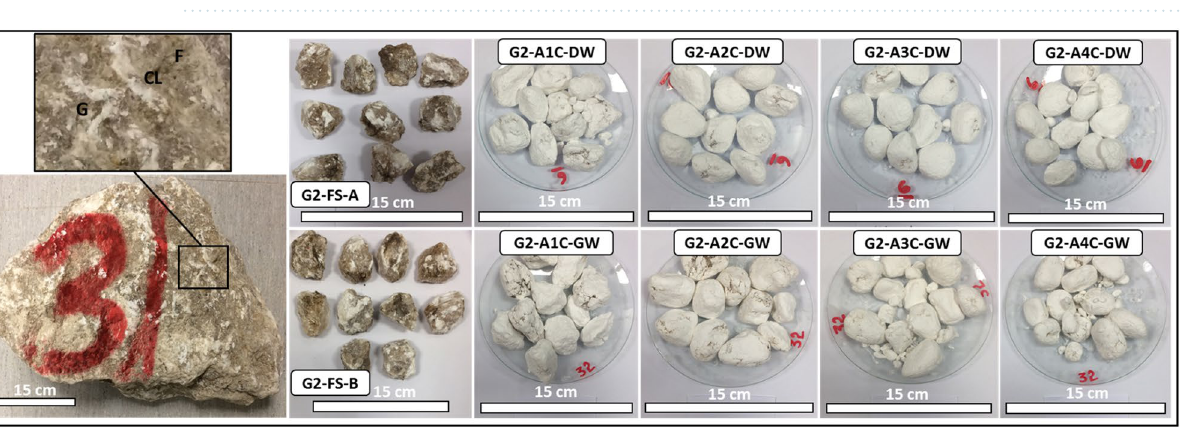
Figure 3. Representative evaporitic rock block (G1–RB; Group 1, Rock Block) and slake durability test samples cycled with distilled water and groundwater (1st–4th cycles). G1-FS-A represents Group 1, fresh sample, sample A, G1-A1C-DW to G1-A4C-DW after 1st–4th cycles with distilled water. G1-FS-B represents Group 1, fresh sample, sample B, G1-A1C-GW to G1-A4C-GW after 1st–4th cycles with groundwater. G = Gypsum, F = Fracture, CL = Clay.